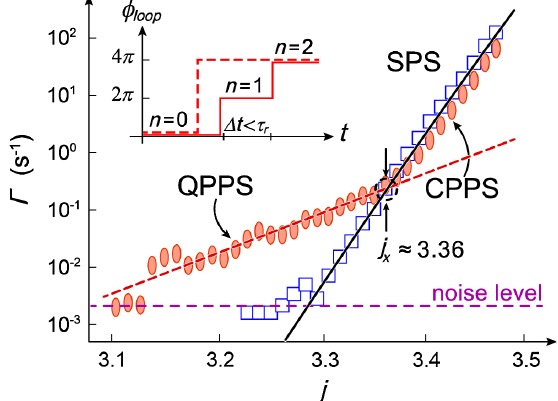
FIG. 6. Rates of SPS (blue squares) and PPS (red ovals) as functions of the normalized current in the solenoid. The bath temperature is 60 mK. Single (blue squares) and paired (red ovals) phase slip rates are obtained from the switching current distributions shown in Fig. 3. The solid black line is the Kurkijärvi-Garg fit for the rate of SPS. The dashed red line is the QPPS fit, generated according to Korshunov ’ s theory of QPPS [14]. Rates of SPS and PPS are equal at the current j x . The inset shows the schematic difference between CPPS (red solid line) and QPPS (red dashed